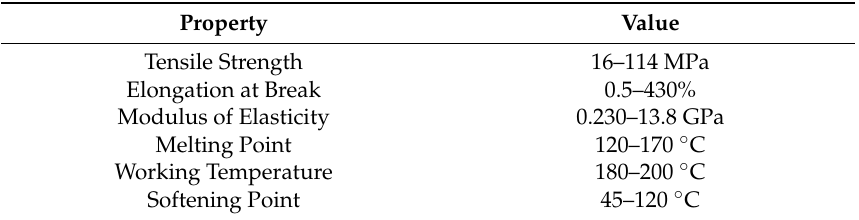
Table 1. Characteristics of the poly(lactic acid) (PLA) according to the manufacturer.